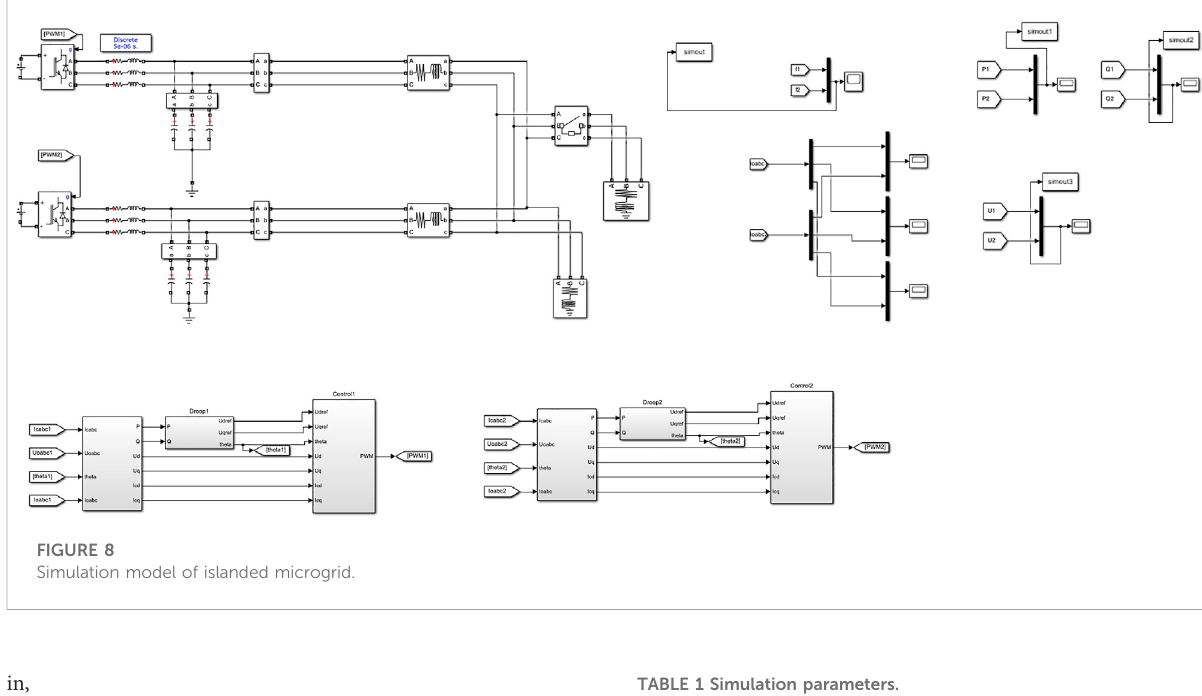
TABLE 1 Simulation